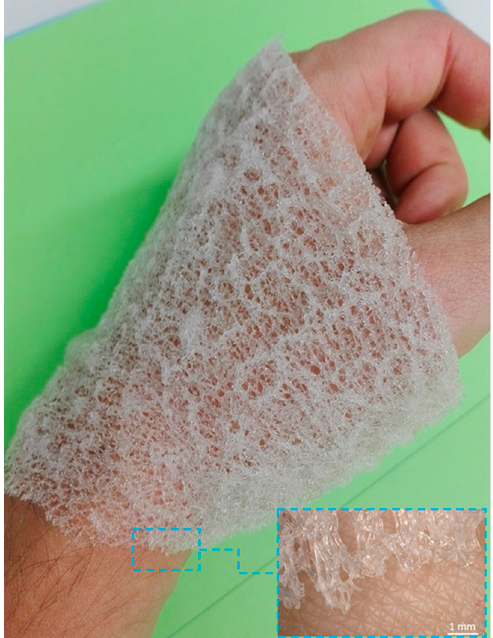
Figure 11. Gauze fabric-like morphology of chitinous scaffold isolated from I. labyrinthus. Such flexible biomaterial can be easily placed on the surface of human skin.